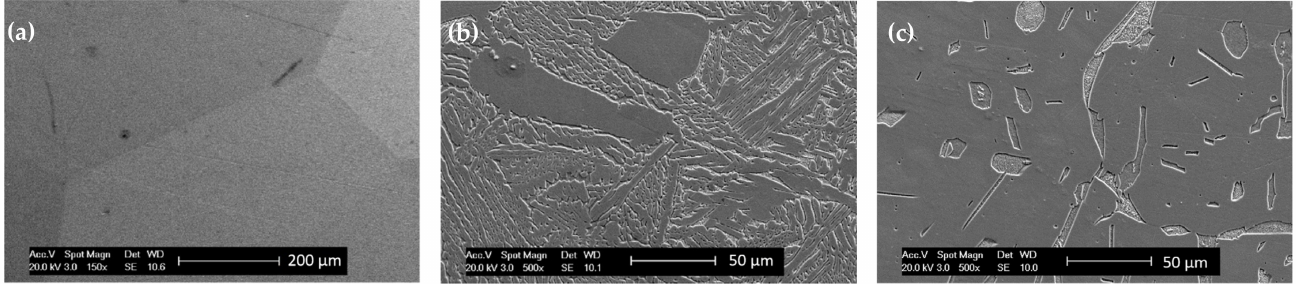
Figure 3. SEM micrographs on longitudinal sections showing the microstructures of ( a ) CuZn42, ( b ) CuZn38As and ( c ) CuZn36, after the selected heat treatment condition